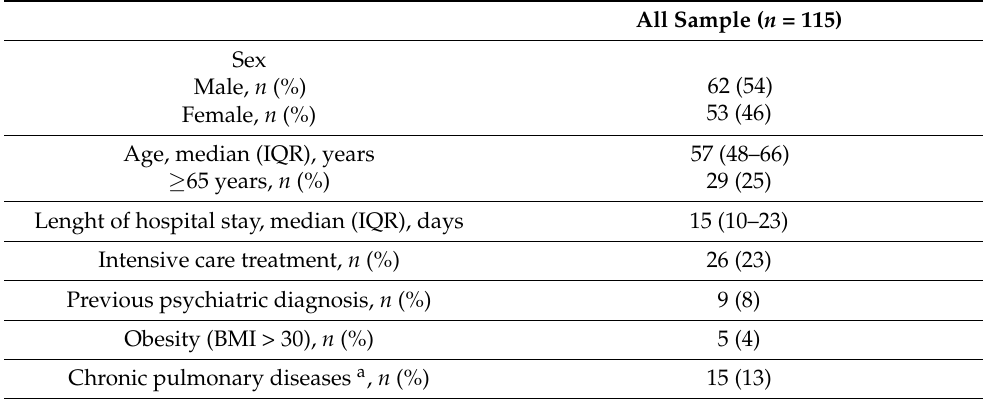
Table 1. Demographic and clinical characteristics of the population.